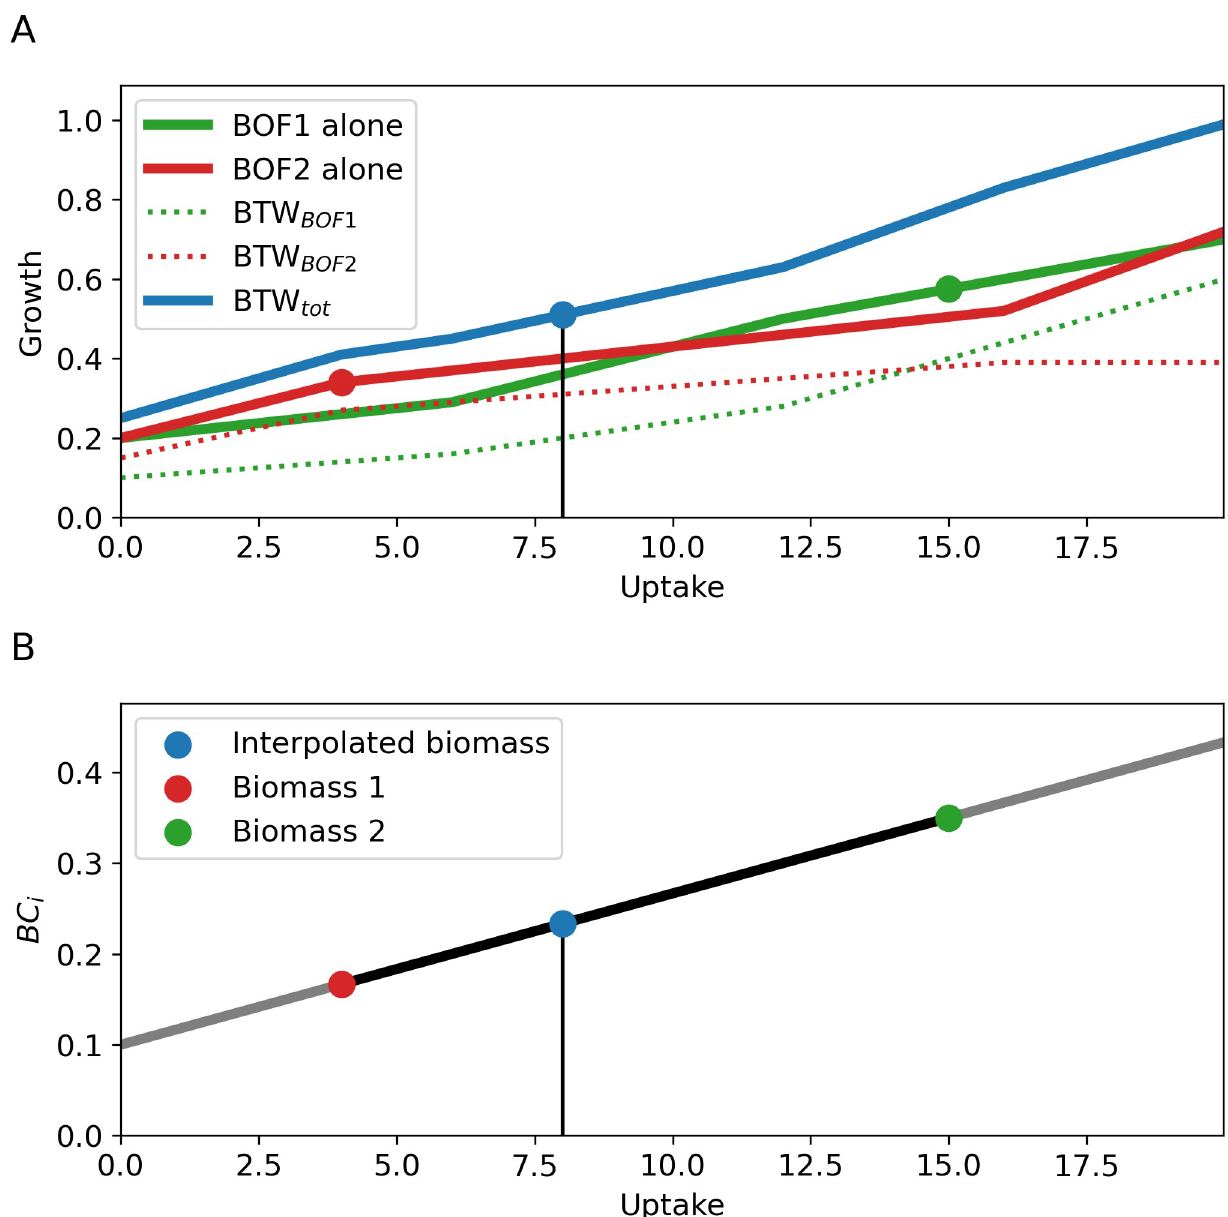
Fig 2. A simple illustration of the principles behind the Biomass Tradeoff Weighting (BTW) and Higher-dimensional-plane InterPolation (HIP) approaches. The green and red point represent a laboratory determined BOF (panel A) or the coefficient of biomass component BC i (panel B) for the given uptake. In both panels, the blue point indicates the response to the specified environment uptake flux. A) An illustration of the BTW, where the linear optimization algorithm is allowed to select an optimal tradeoff between multiple BOFs in order to maximize total biomass production. The fluxes through the different BOFs are combined for an optimal objective value, represented as the blue combined biomass. The green and red solid line represent the use of each single BOF, the dotted lines their contribution to the BTW BOF. B) A schematic depiction of HIP, which uses environmental parameters to interpolate between different known levels of biomass component coefficients BC i to generate coefficients for a new BOF. In contrast to BTW, the BOF is depending on the environment and nutrient data.